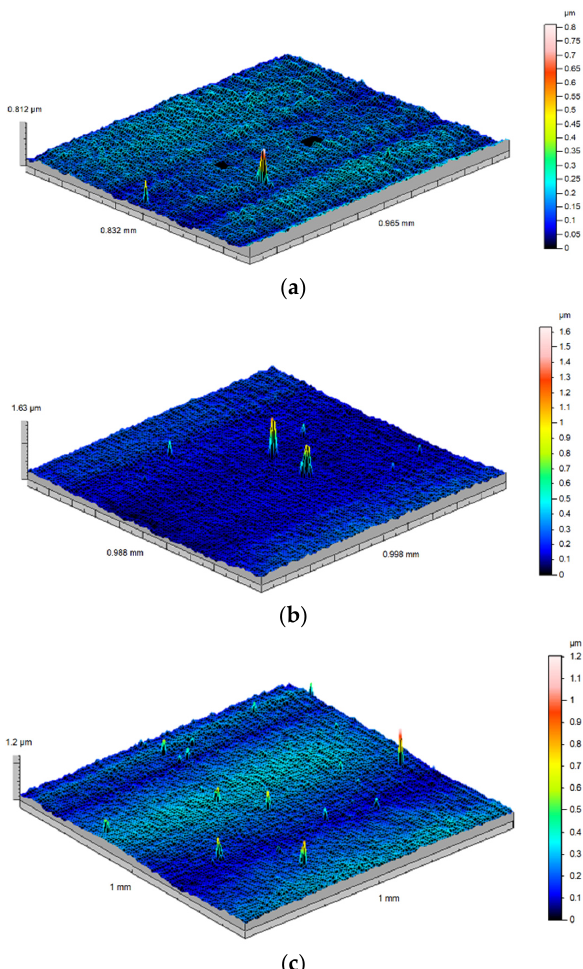
Figure 5. Surface topography of ( a ) WC–Co, ( b ) W–B film, ( c ) W–Ti–B film (scanning profilometer).